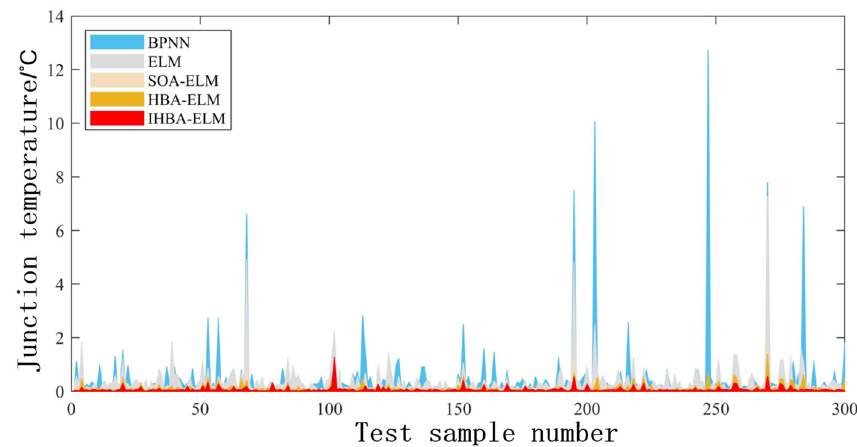
Figure 12. Predicted junction temperature of the BPNN model.